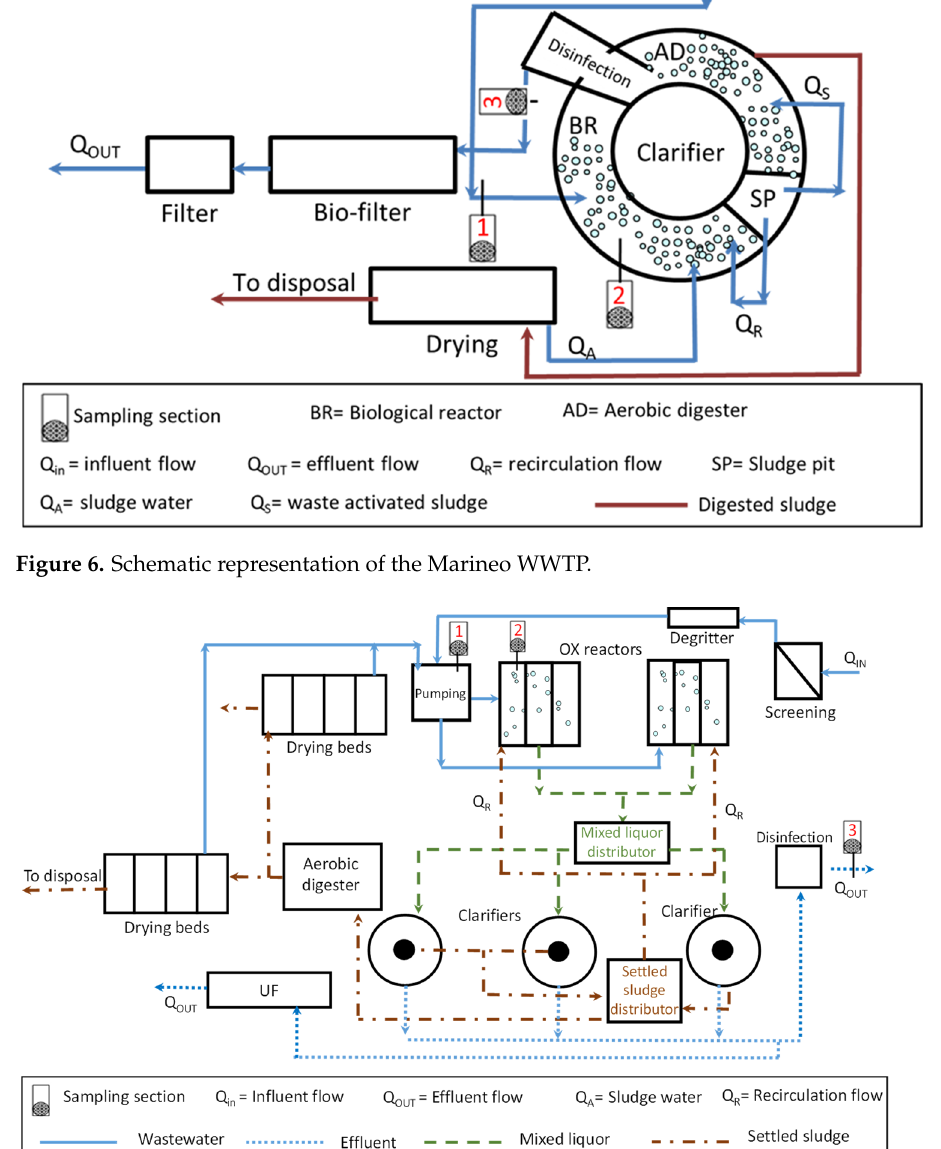
Figure 7. Schematic representation of the Corleone WWTP.